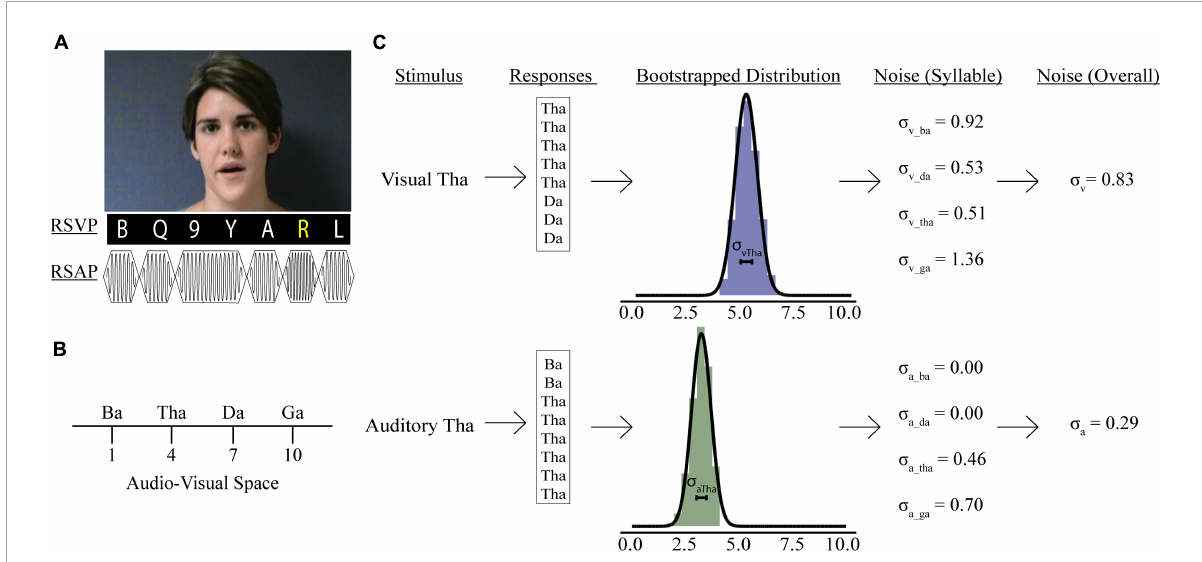
FIGURE1 Psychophysics tasks and sensory noise calculations. (A) Participants watched videos of a woman speaking one of four syllables, after which they reported if she said: “ba,” “ga,” “da,” or “tha.” Rapid serial visual presentation (RSVP) or rapid serial auditory presentation (RSAP) stimuli accompanied speech videos during no load (NL), low load (LL), and high load (HL) blocks. For the visual distractor task, participants detected a yellow letter (LL) or a white number (HL). For the auditory distractor task, participants detected a high-pitched tone (LL) or a long-duration tone (HL). Identifiable human image used with permission. (B) Mapping of possible responses in representative audio-visual space. Panel (C) shows sensory noise calculations for an example participant. Sensory noise was calculated for each participant using responses from visual (top) and auditory (bottom) only trials. Gaussian distributions of these responses were determined via bootstrapping (middle), and the standard deviation of this distribution was calculated for each syllable. The overall visual (top, last panel) and auditory (bottom, last panel) noise for each participant was calculated as the average standard deviation of all syllabi within each